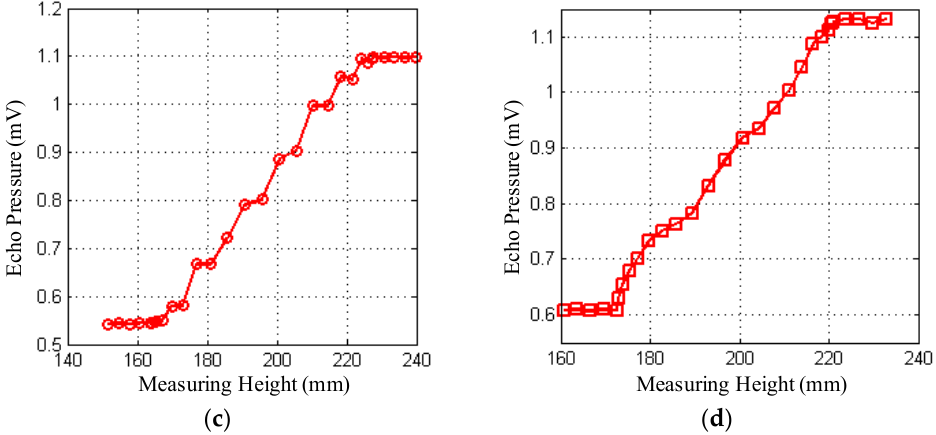
Figure 6. Variation of echo pressure at various wall thicknesses. ( a ) L = 8 mm, 2a = 15 mm; ( b ) L = 8 mm, 2a = 20 mm; ( c ) L = 50 mm, 2a = 15 mm; ( d ) L = 50 mm, 2a = 20 mm.